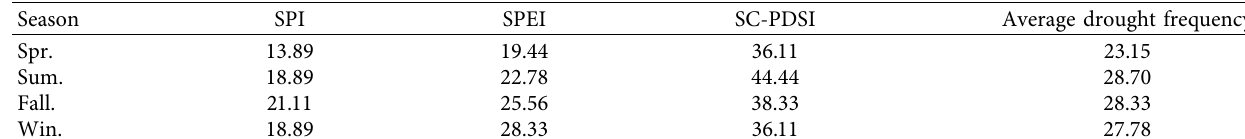
Figure 4: Seasonal changes in the drought indexes in (a–c) spring, (d–f) summer, (g–i) autumn, and (j–l) winter. ∗ 0.05 significance level. Table 3: Frequency of droughts in each season